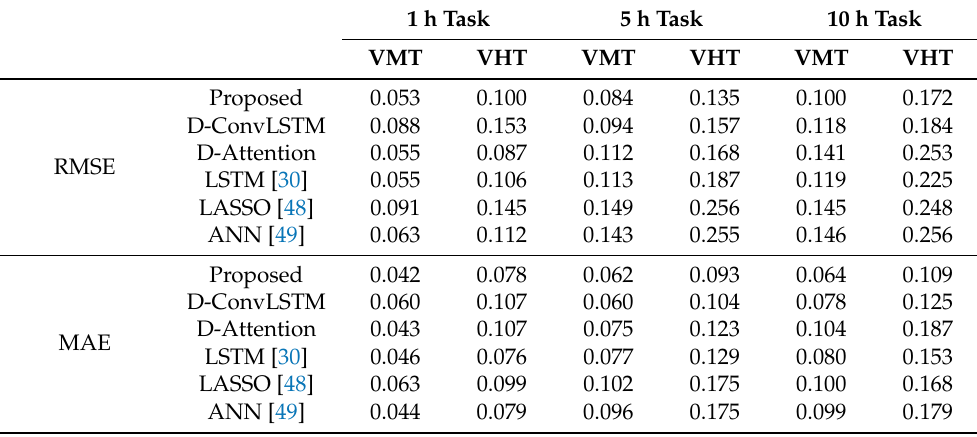
Table 7. The traffic flow prediction errors in terms of RMSE and MAE for the proposed methods and other data-driven methods under the second